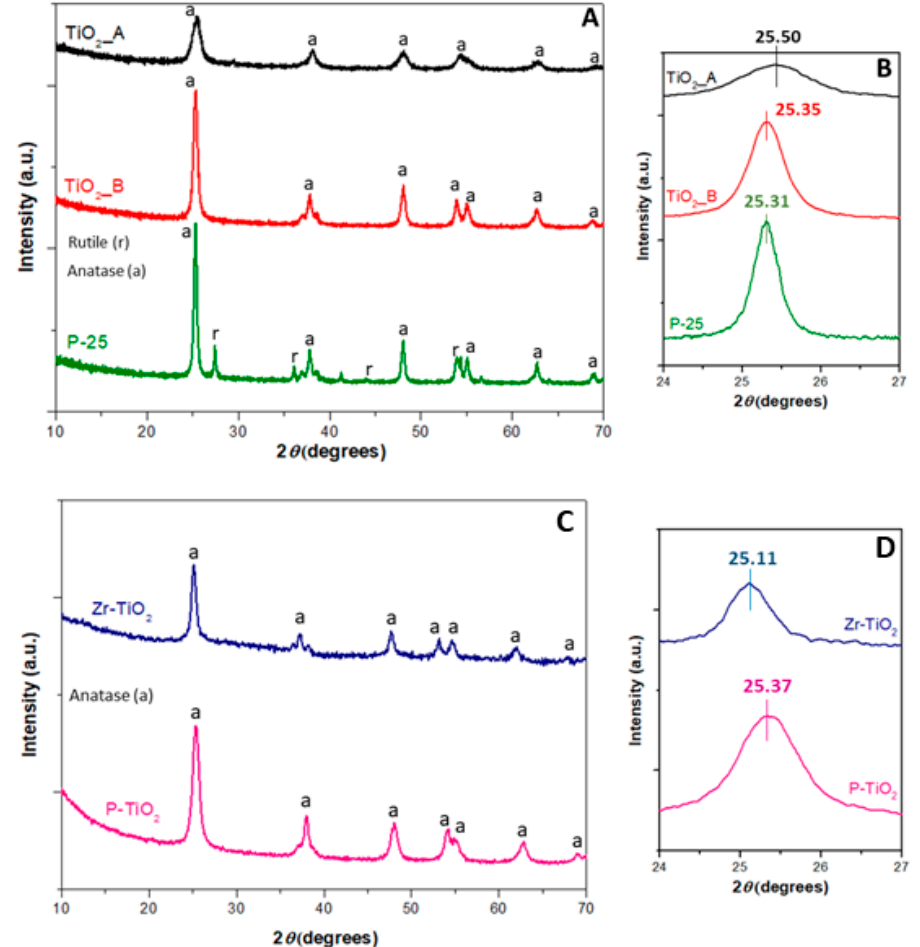
Figure 1. XRD patterns of pure and doped titania samples ( A and C , respectively) and the magnifications of the main peaks ( B and D ,